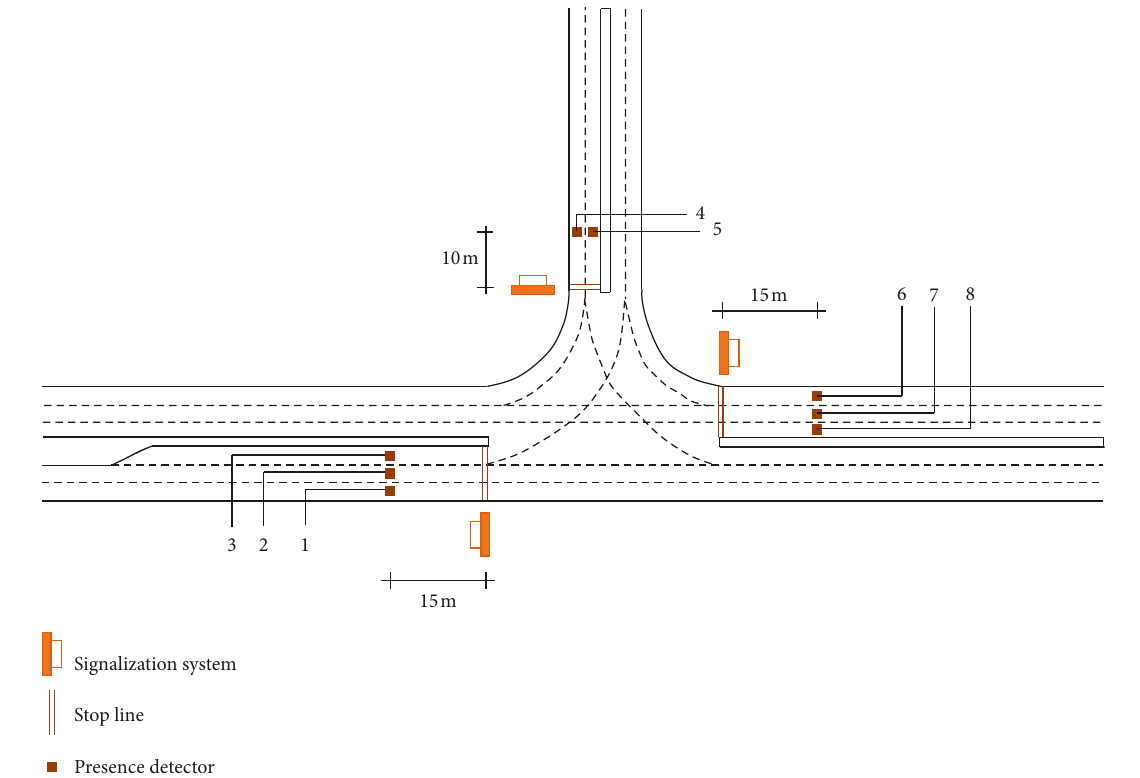
Figure 6: The location of detectors for vehicle-actuated